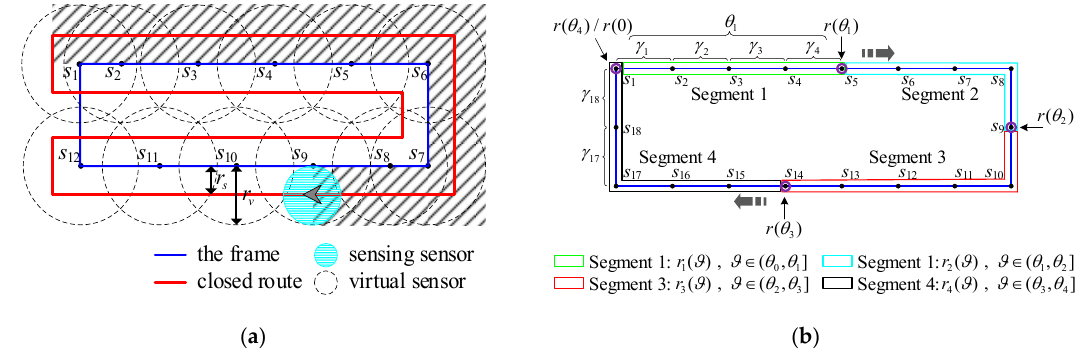
Figure 9. ( a ) The schematic diagram of the closed route for complete coverage generated by the frame. The radius of each robot is r s and the radius of virtual sensor is r v , which satisfies r v = 2 r s . The shaded area is the field that robots have scanned. ( b ) An example of path partition. Segment 1 is inside the green box. Segment 2 is inside the cyan box. Segment 3 is inside the red box. Segment 4 is inside the black box. Termination point of each segment is inside the purple